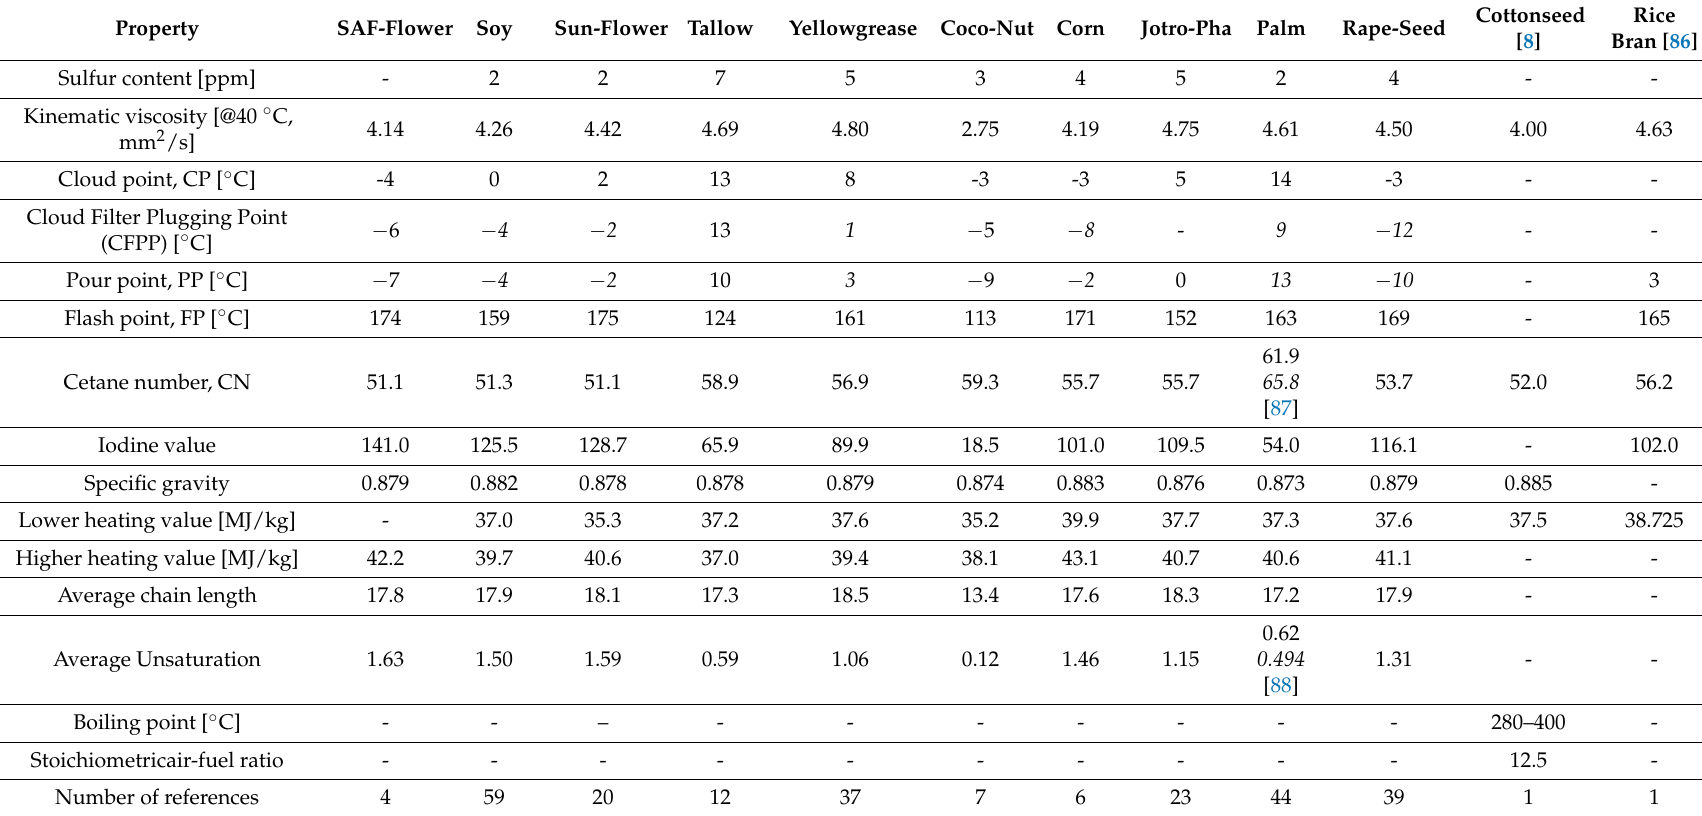
Table 3. Physico-chemical properties of biodiesel from different feedstocks [8,85,86]. SAF-Flower Soy Sun-Flower